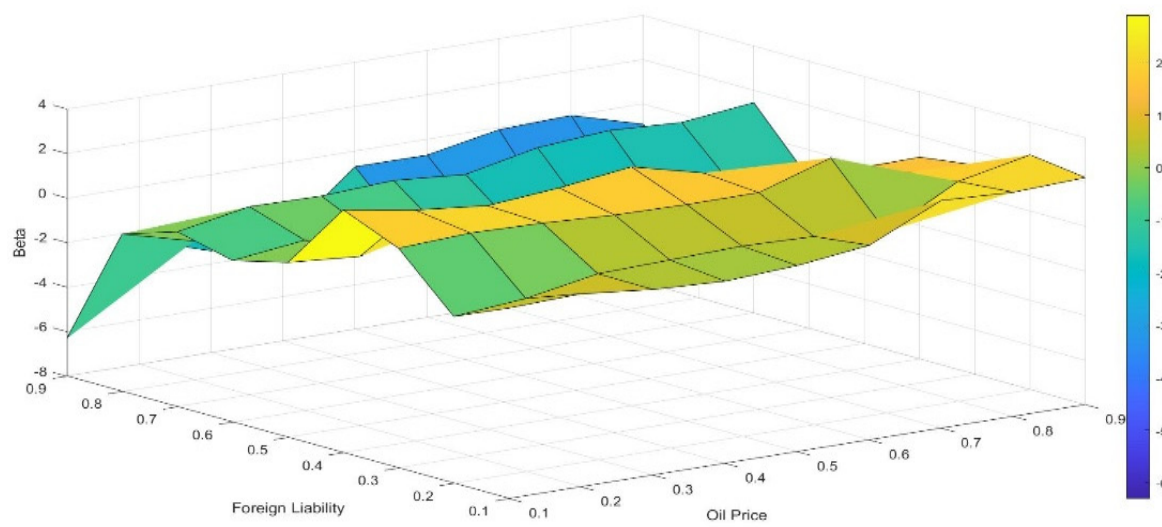
Figure 7. Response of foreign liability to oil price. Quarterly data.